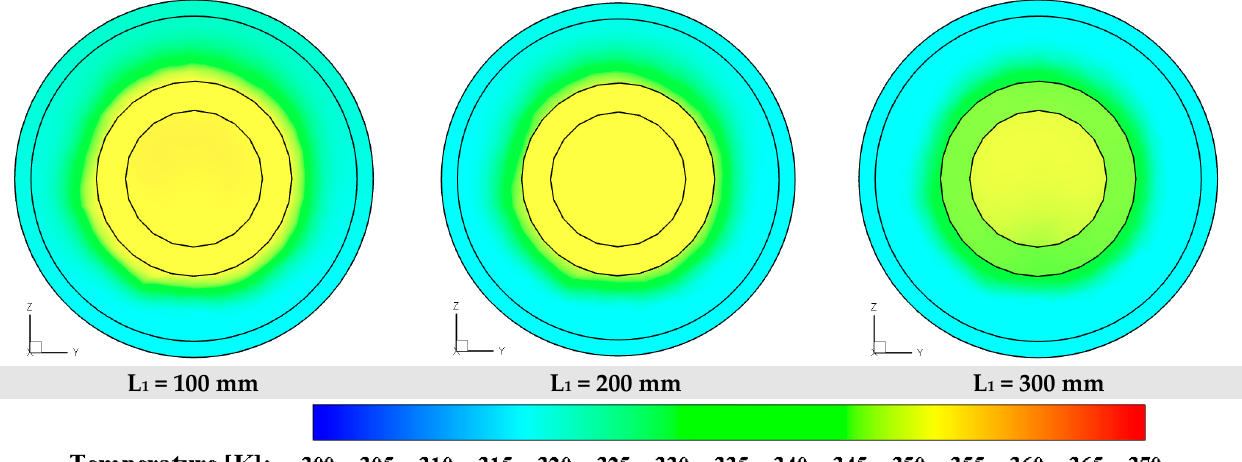
Figure 11. The temperature contours at outlet ports for different lengths of proposed swirl generator (L1) at S = 0.3 π mm at m (cid:4662) = 0.043 kg/s.